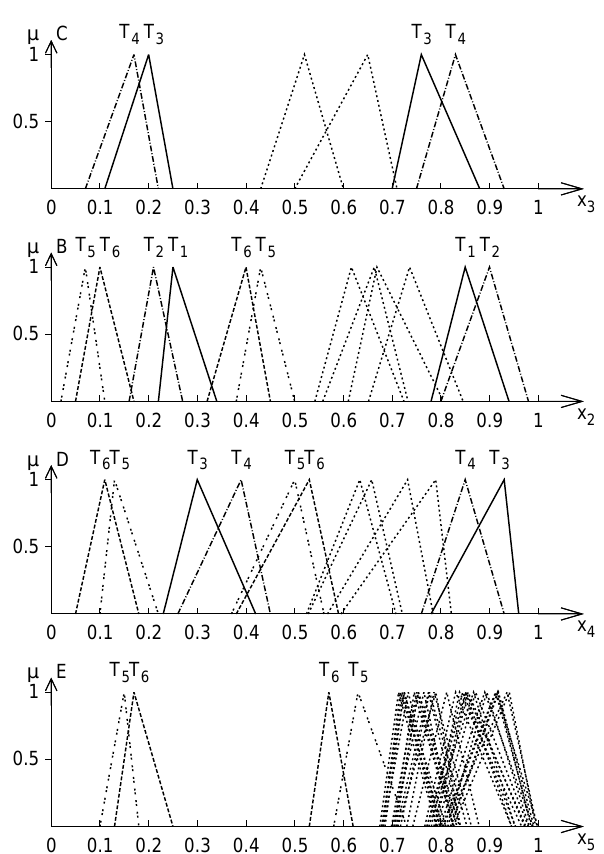
Figure 9. Interpolated results from conventional FRI [23].